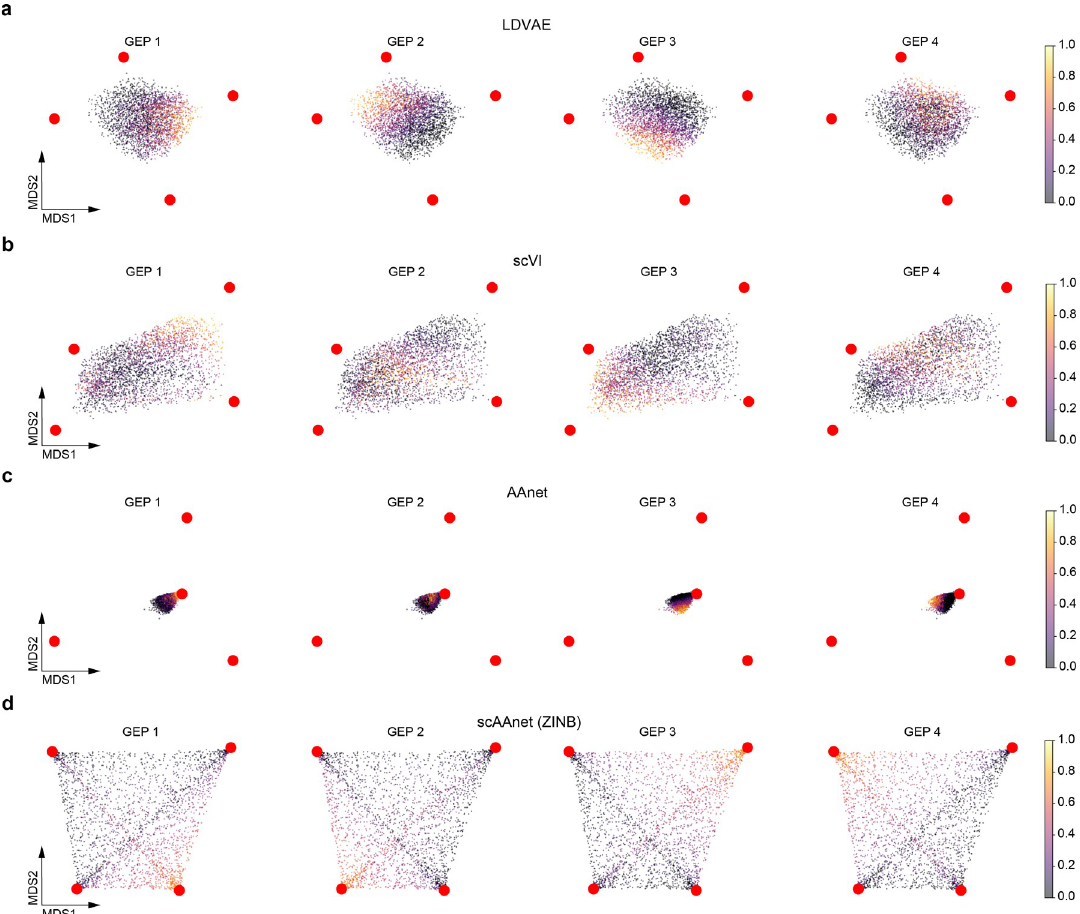
Fig 3. MDS interpolation visualization of archetypal space. (a) MDS visualization of archetypal space recovered from LDVAE. (b) MDS visualization of archetypal space recovered from scVI. (c) MDS visualization of archetypal space recovered from AAnet. (d) MDS visualization of archetypal space recovered from scAAnet using ZINB loss. Red dots are the locations of the inferred archetypes. Figures in each column are colored by the true cell usage of the corresponding archetype (GEP). Similar results of scAAnet using other distribution-based loss terms can be found in S2